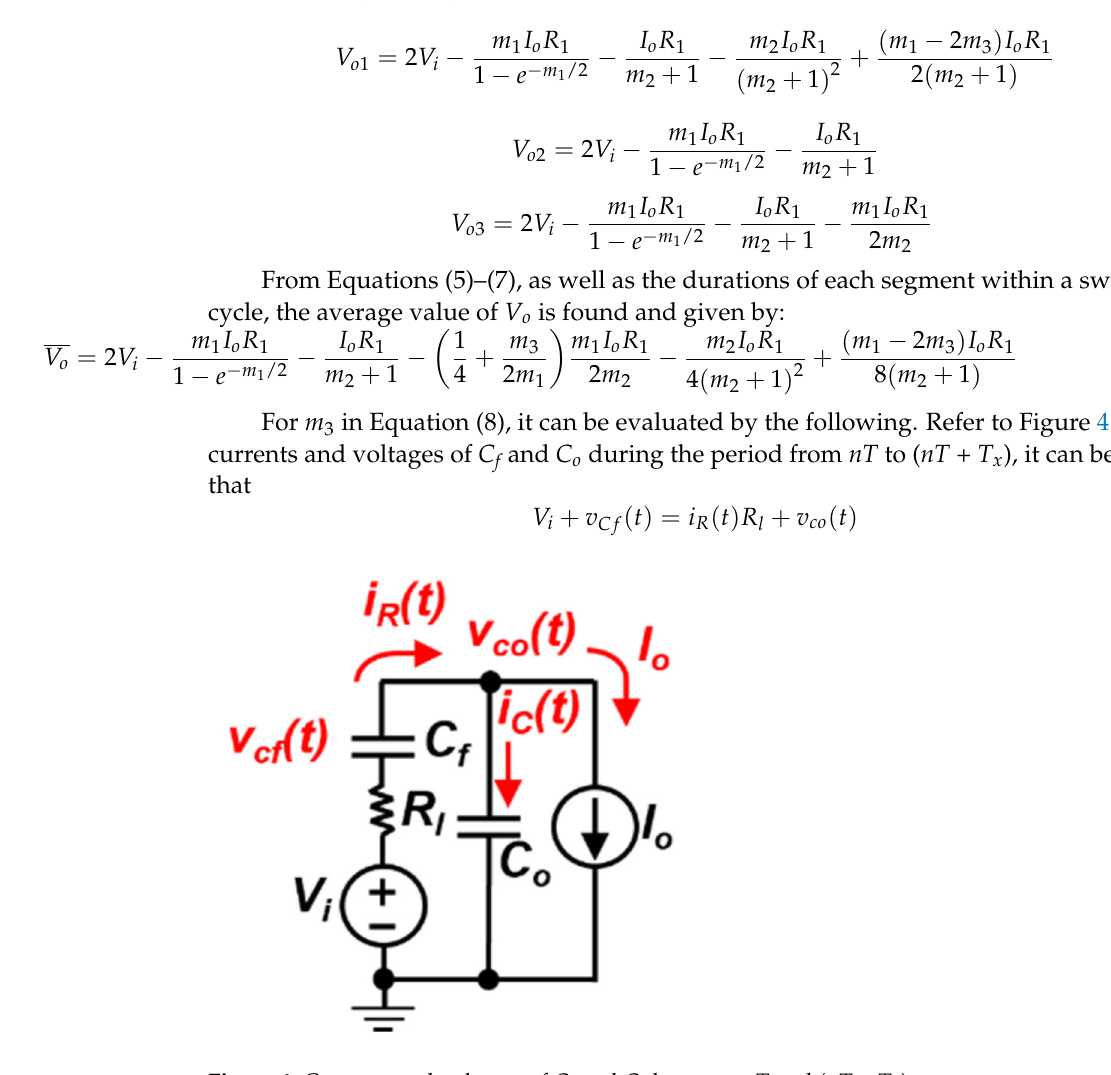
Figure 4. Currents and voltages of C f and C o between nT and ( nT + T x